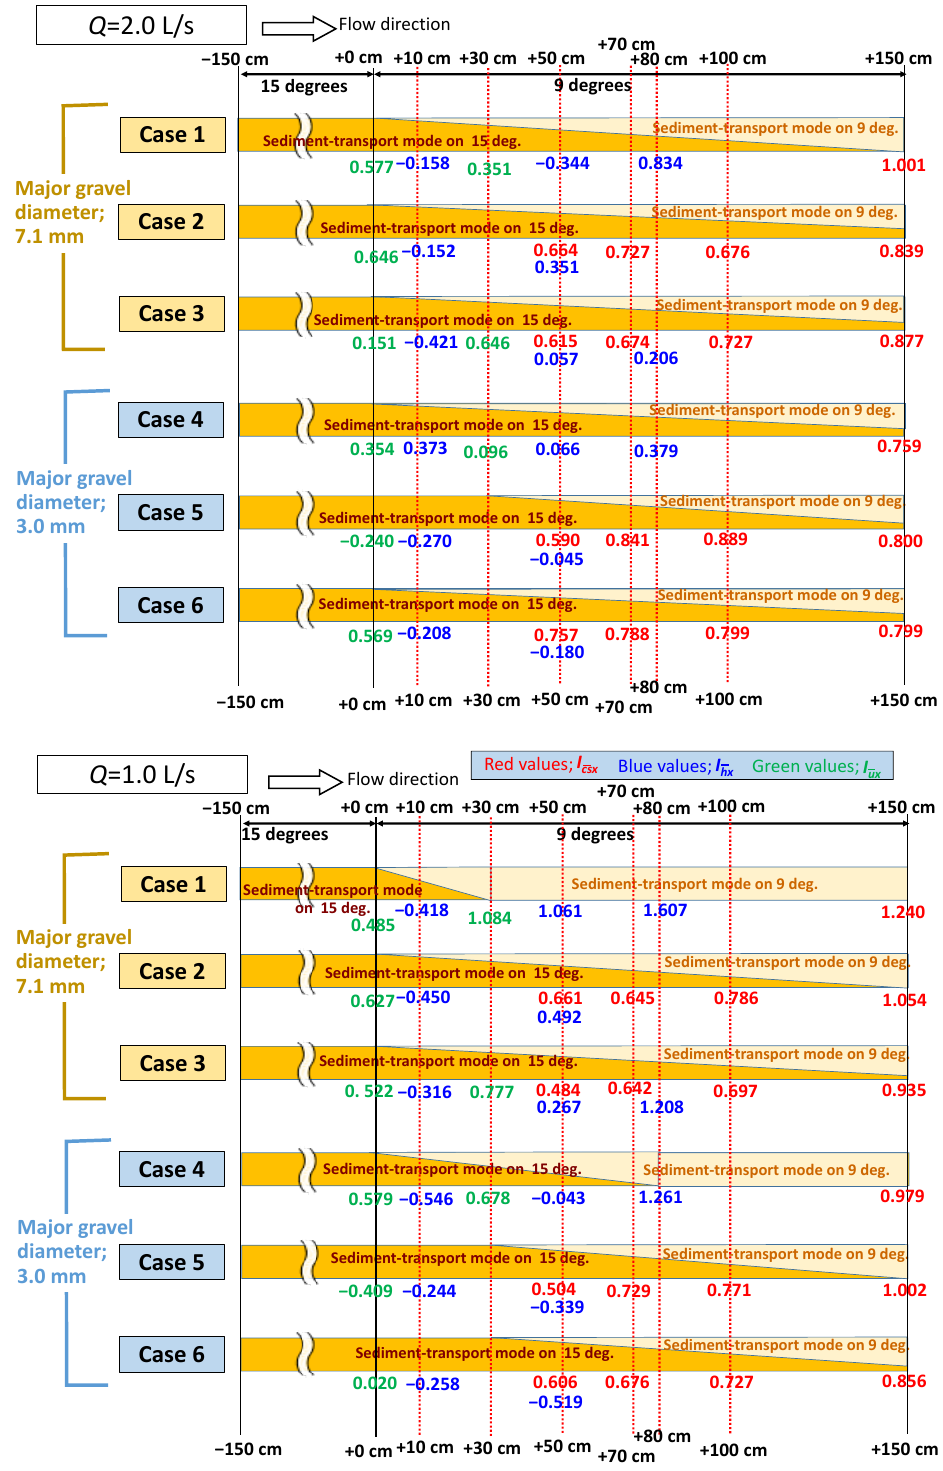
Figure 9. Estimated longitudinal transition processes of sediment transport modes of the “frontal part” of the debris flow for all cases, based on the transition indices. Red, blue, and green values in the figure are the transition indices of sediment transport modes at x cm downstream from the gradient change point for the sediment transport concentration, the averaged flow depth, and the vertical averaged gravel migration velocities at the “ frontal part ” of the debris flow, i.e., 𝐼 𝐶𝑠̅̅̅𝑥 , 𝐼 ℎ̅𝑥 , and 𝐼 𝑈̅𝑥 .